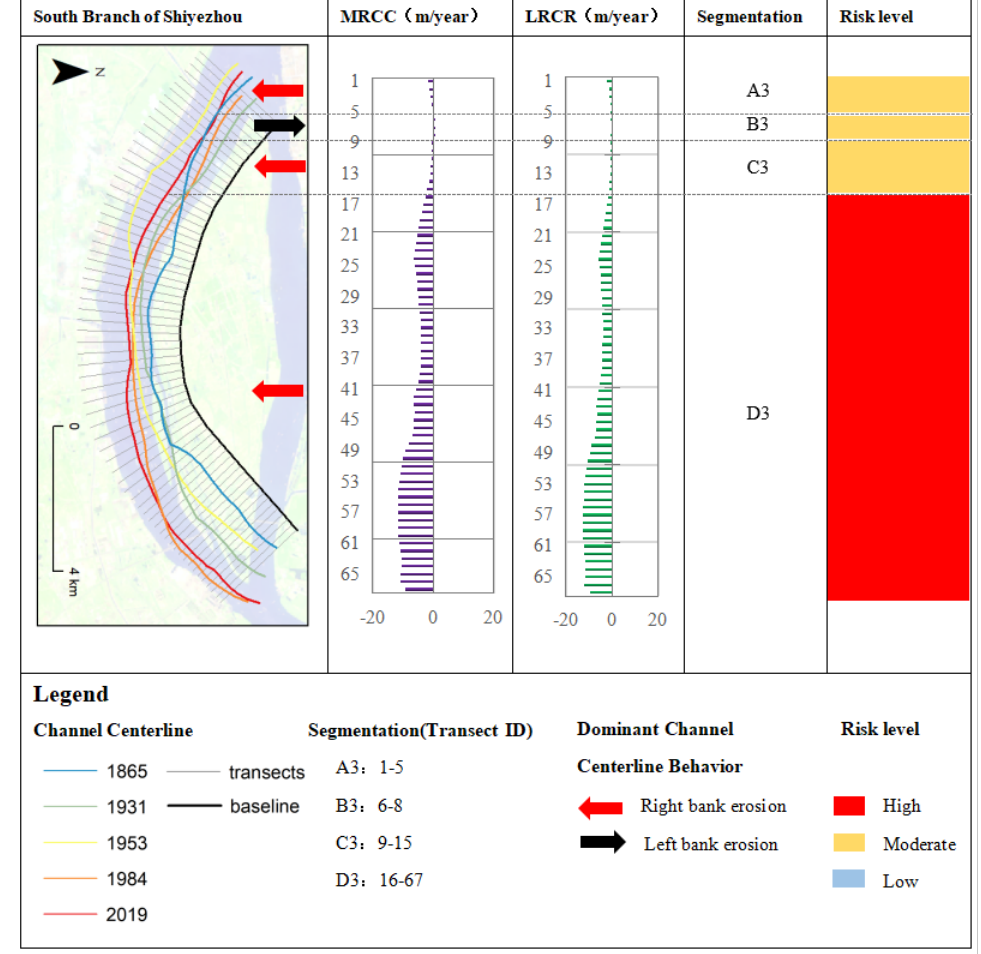
Figure 7. The Migration Rate of Channel Centerline, Linear Regression Change Rate, and erosion risk identification on south branch of Shiyezhou.